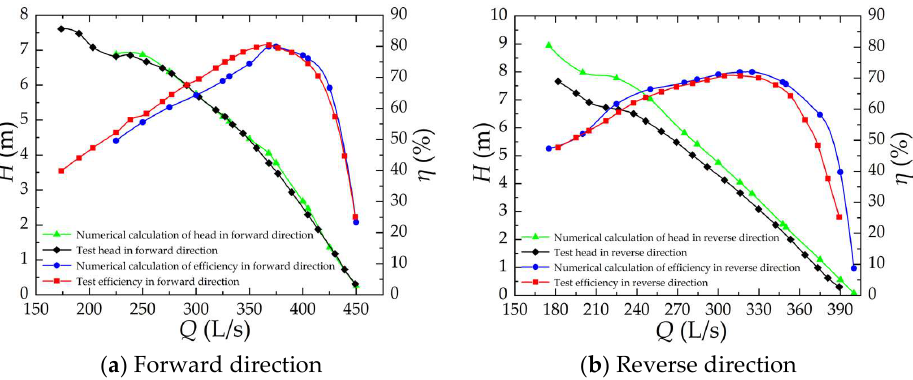
Figure 6. Comparison curve of numerical calculation and test energy